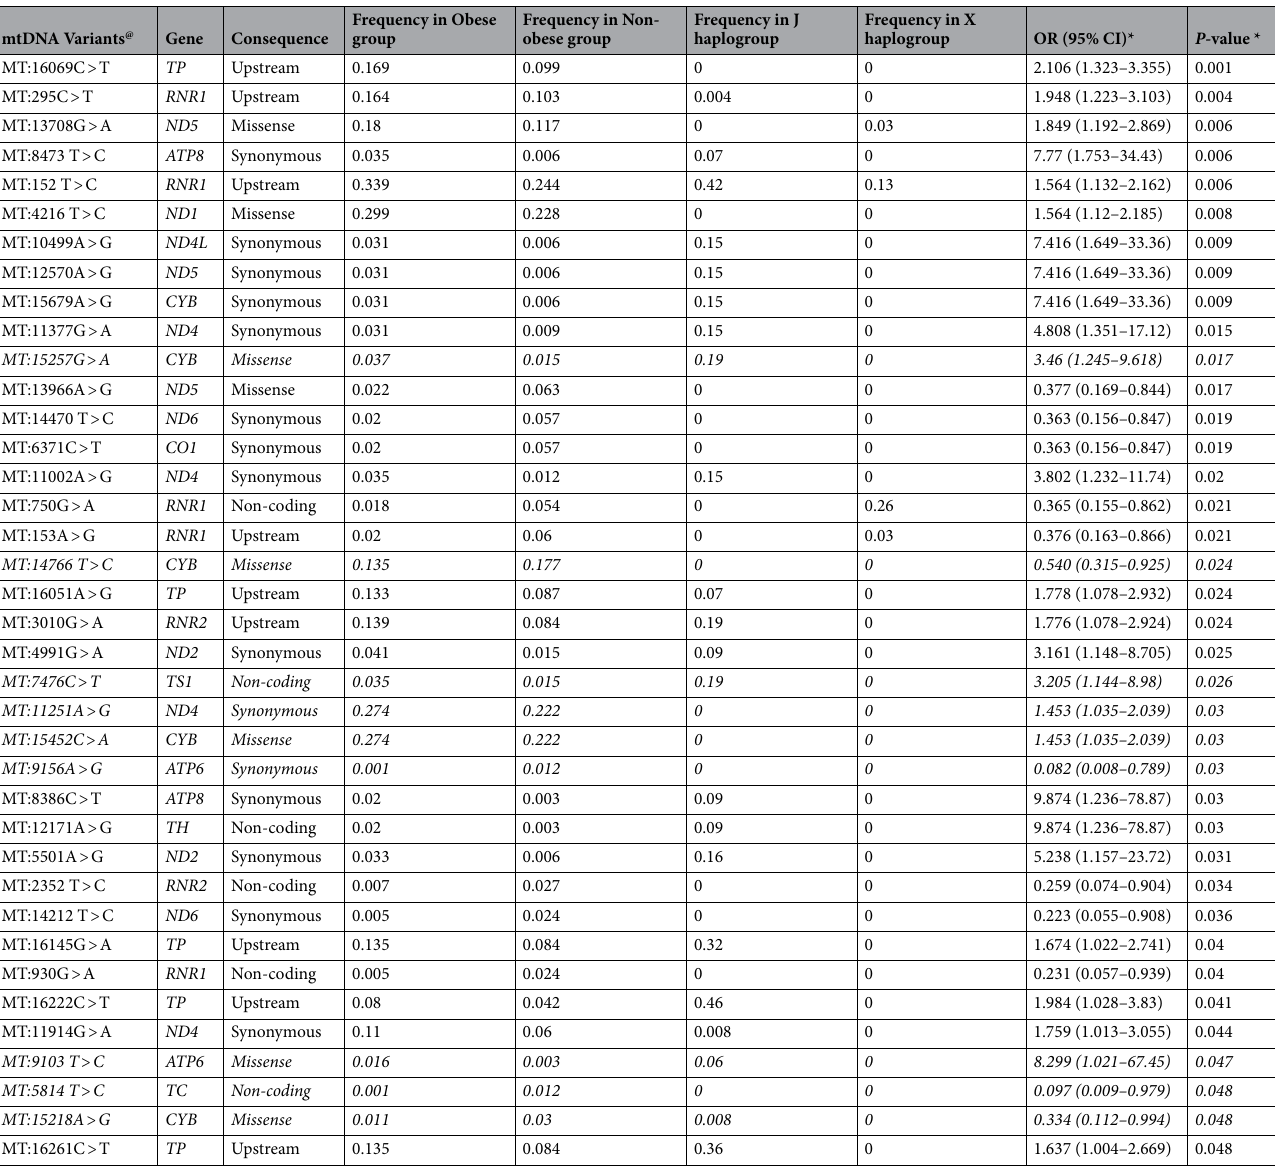
Table 4. Mitochondrial variants associated with obesity in Qatari population. *Values after adjustment for age, sex and maternal haplogroup; 8 of the listed variants in the table did not attain significant P-values (≤ 0.05) when the model was not adjusted for age, sex and haplogroup—such variants are shown in italics font. Abbreviations: OR, odds ratio; CI, confidence intervals. @ Conditional analysis using the top leading MT:16069C > T variant with the lowest p-value as the conditioning SNP, identified 14 of the remaining variants remaining as significant. We assume that these 14 variants to have an independent effect on the